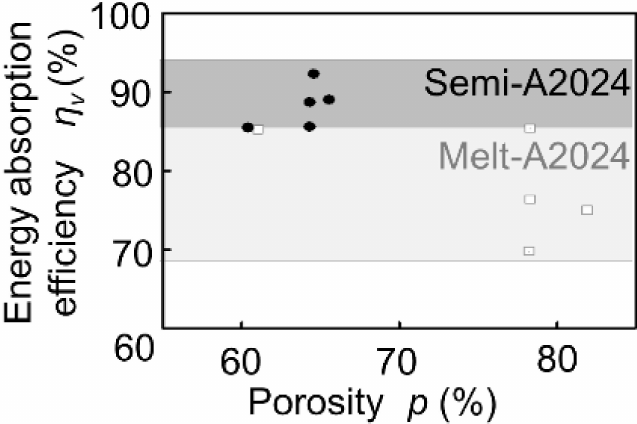
Figure 3. Energy absorption efficiency η V of Melt-A2024 and Semi-A2024.